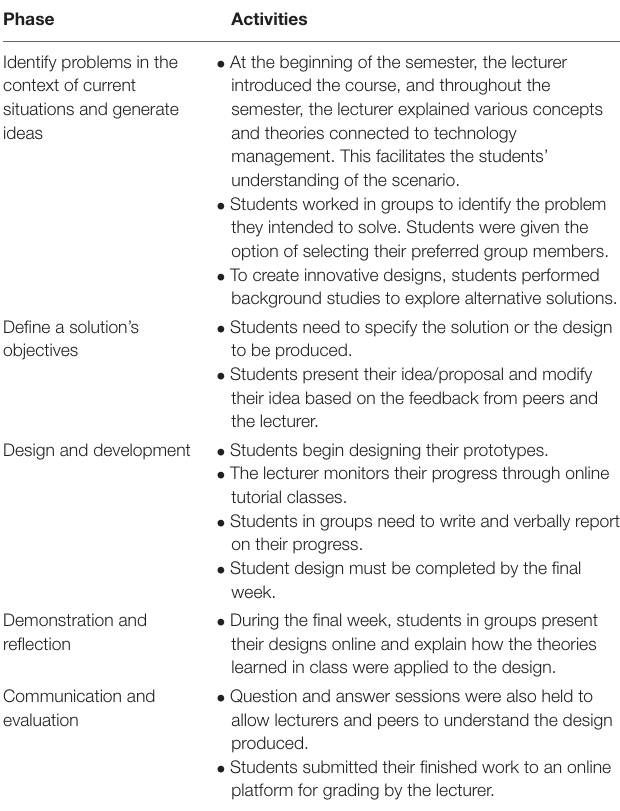
TABLE 1 | Application of the design-based research